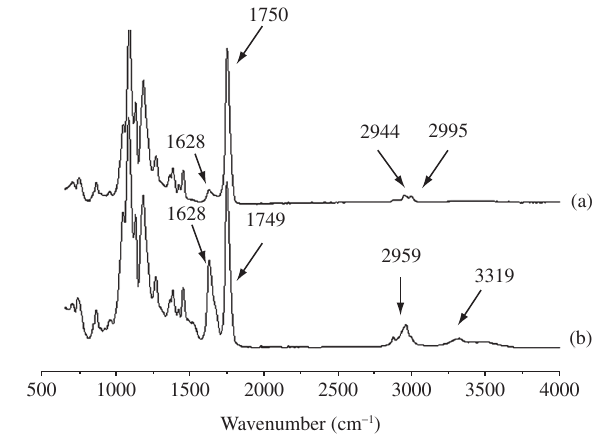
Figure 6. FTIR spectra in the role wavelength range (1500-4000 cm –1 ) of the samples: a) powders PLGA 75:25 and CyA in ratio 100:10, respectively and b) mixture